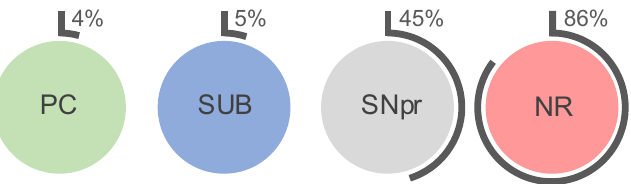
Figure 6. Percentage of PN + neurons as obtained by single cell counting during slide-based cytometry. PN + and PN – neurons were counted in the left and right hemispheres and averaged over 14 brain slices from two rats (seven slices each). Total cell counts within the selected ROIs were 42,593 (PC), 12,301 (SUB), 2958 (NR), and 2726